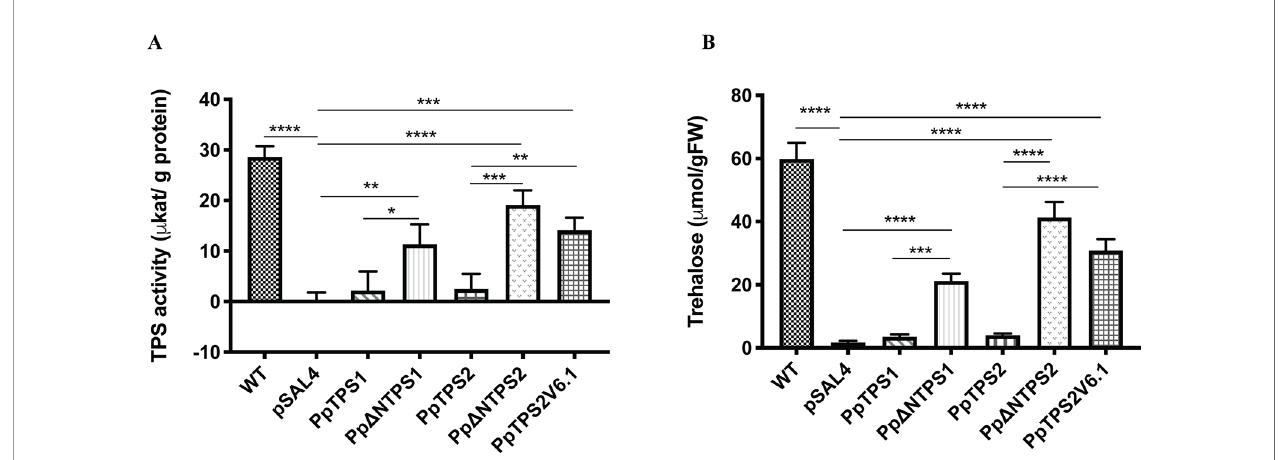
FIGURE 4 | (A) TPS activity and (B) trehalose measurements in the yeast tps1 D mutant transformed with PpTPS1 , PpTPS2 , or PpTPS2V6.1 . Cells were grown on synthetic medium lacking uracil supplied with 2% galactose. Data represent the mean ± SD of three biological repeats. Statistical analysis with one-way ANOVA, *p ≤ 0.05, **p ≤ 0.01, ***p ≤ 0.001, ****p ≤